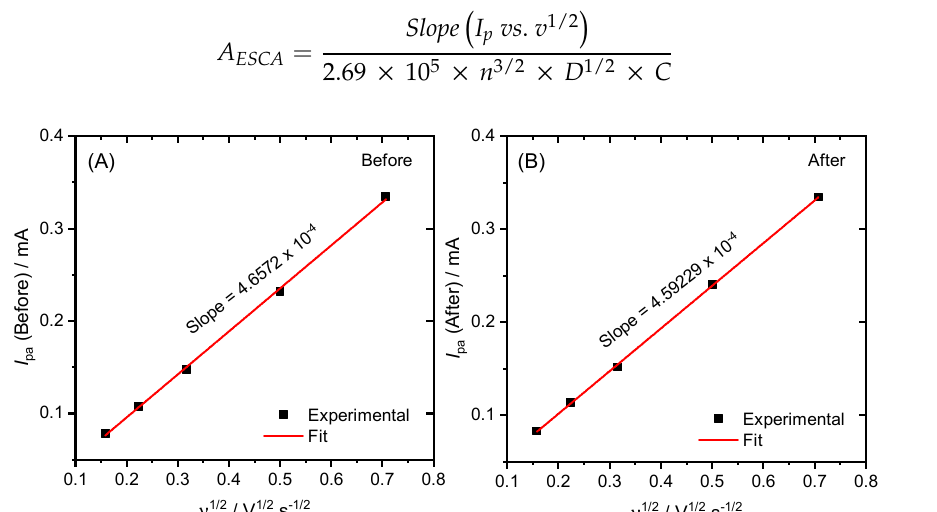
Figure 6. The plots of anodic peak current ( I pa ) versus ν − 1/2 (derived from Figure 5) before ( A ) and after ( B ) assembling MoS x monolayer on Au disc.